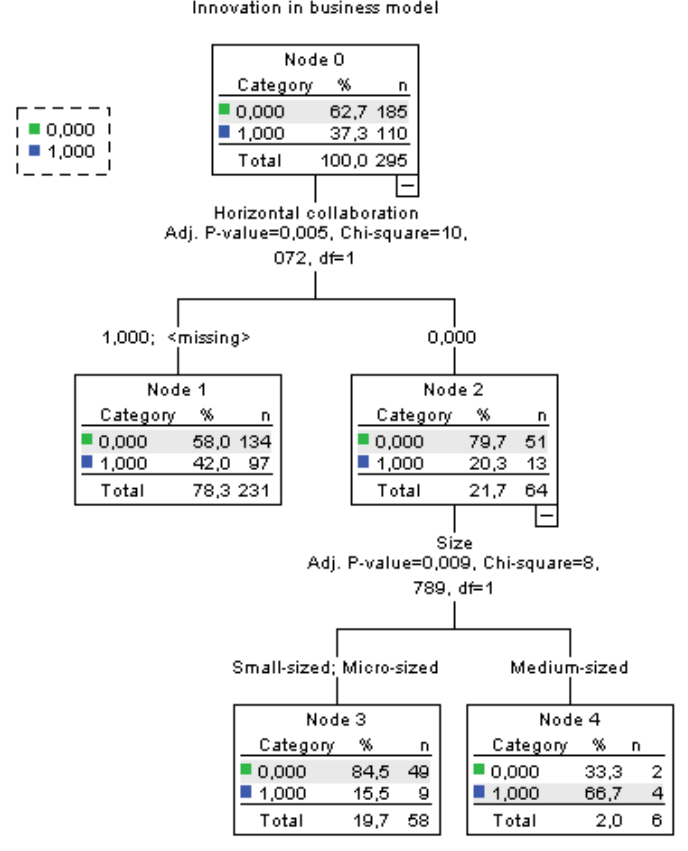
Figure 5. Determinants of innovation in business